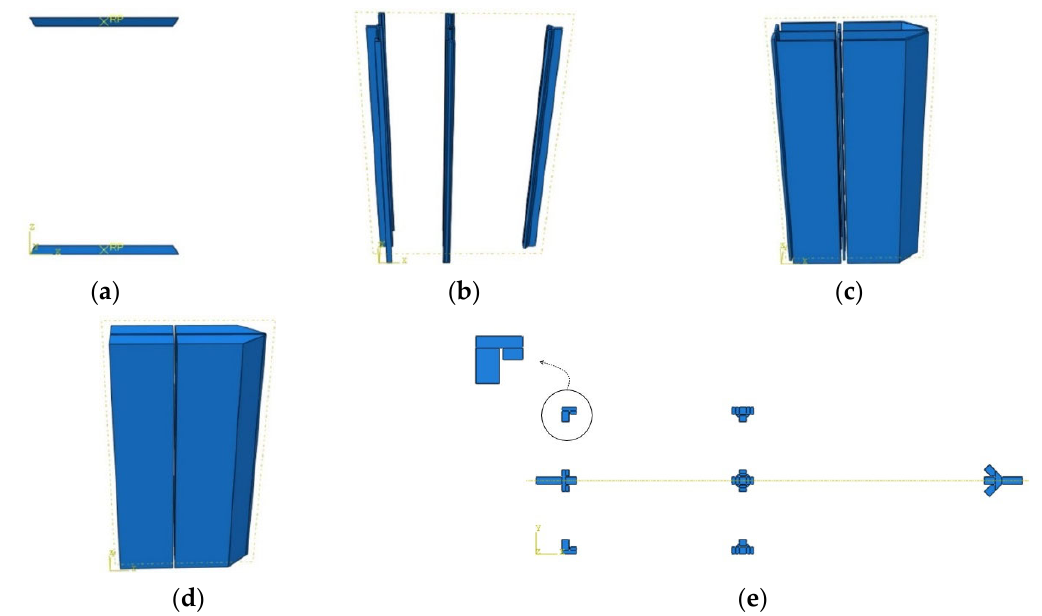
Figure 10. Parts of the FEM model and weld details (PEN5 and PEN6). ( a ) Loading plates; ( b ) Welded corners; ( c ) Plates of the steel tube; ( d ) Concrete core; ( e ) Weld details.